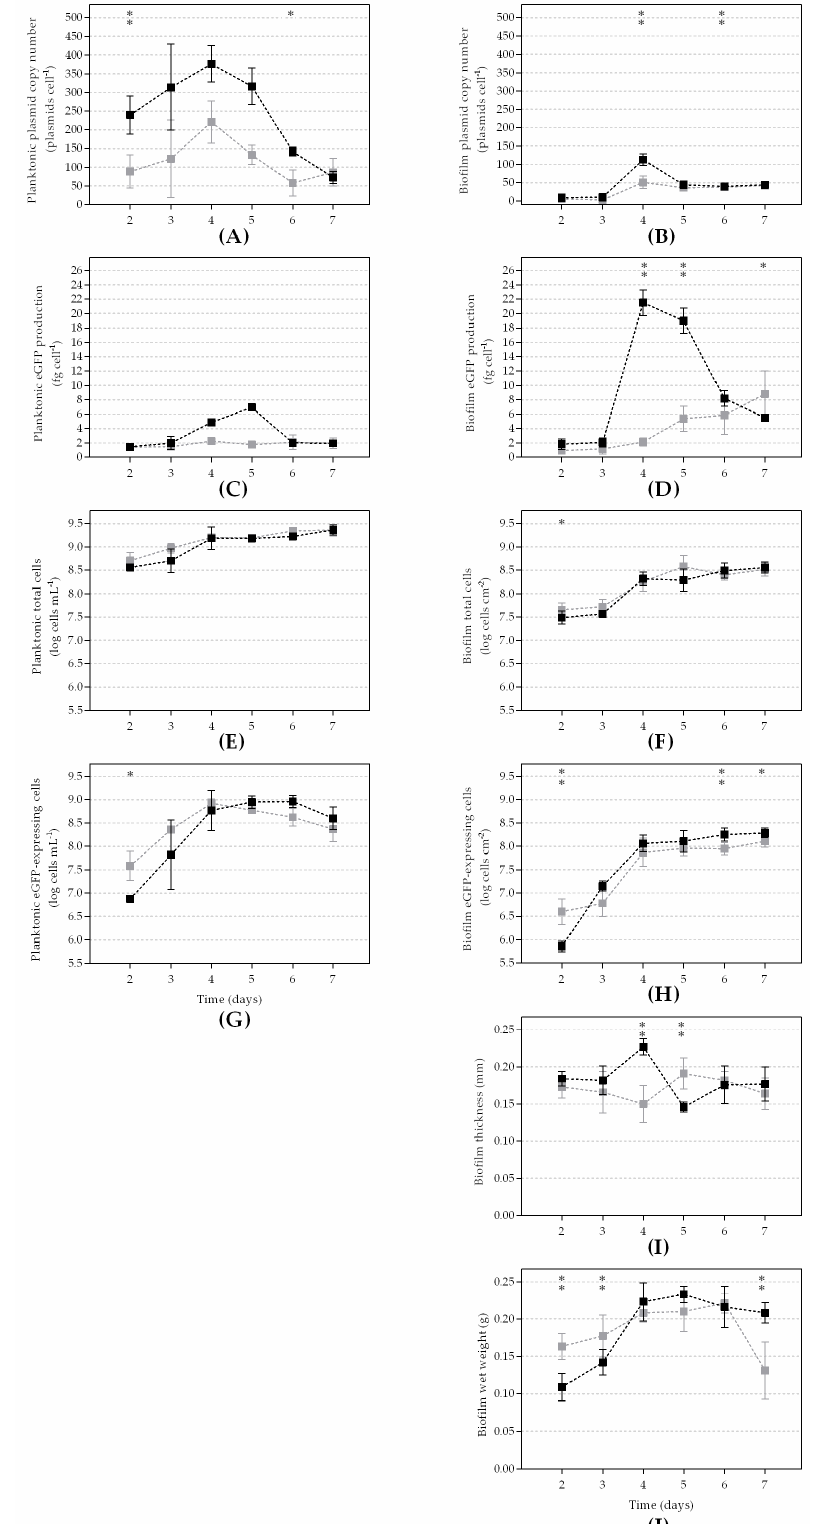
Figure 1. Planktonic and biofilm parameters at a flow rate of 255 L h − 1 ( Re of 4600; dark squares) Figure 1 and 128 L h − 1 ( Re of 2300; gray squares): ( A ) planktonic plasmid copy number; ( B ) biofilm